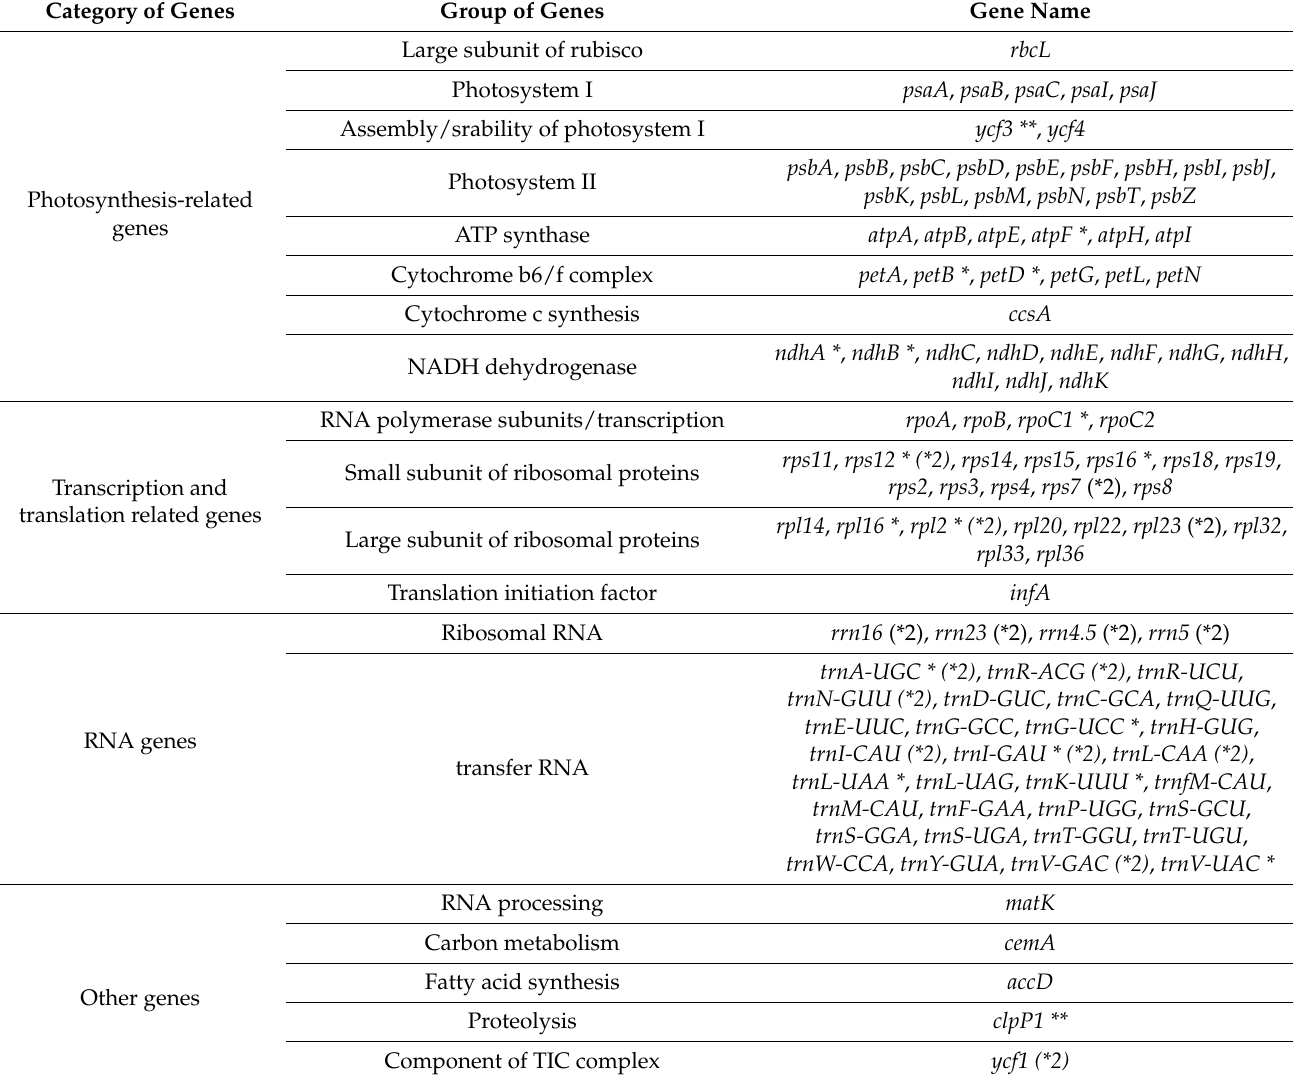
Table 2. Genes predicted in the chloroplast genome of Benincasa hispida . The number of asterisks after the gene names indicates the number of introns contained in the